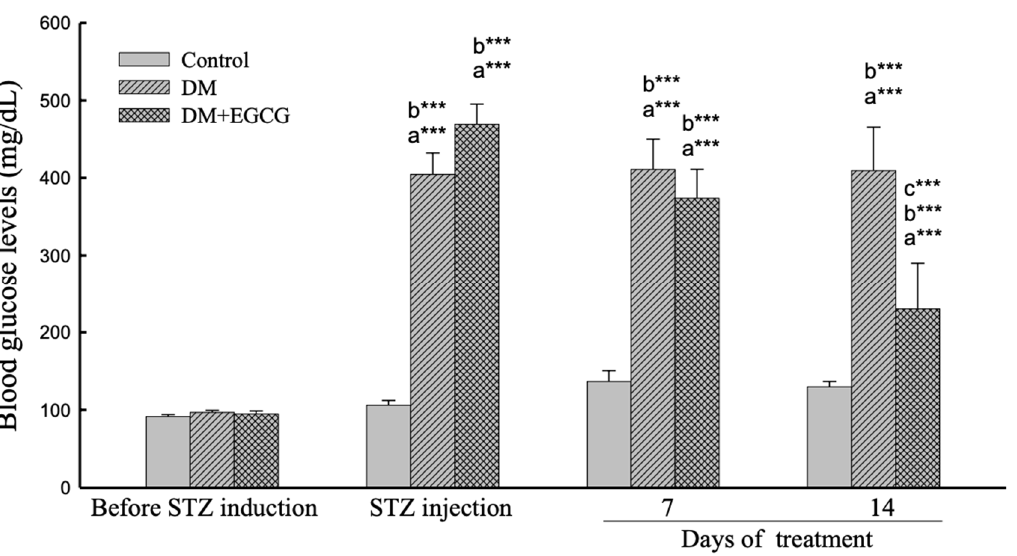
Figure 2. Blood glucose levels. The data were expressed as mean ± SEM. ***, p < 0.001. (a), compared to the control group at the same time point (7 days or 14 days); (b), compared to the same group before STZ injection; (c), compared to the DM group at the same time point. DM, diabetes mellitus; EGCG , epigallocatechin gallate; STZ,